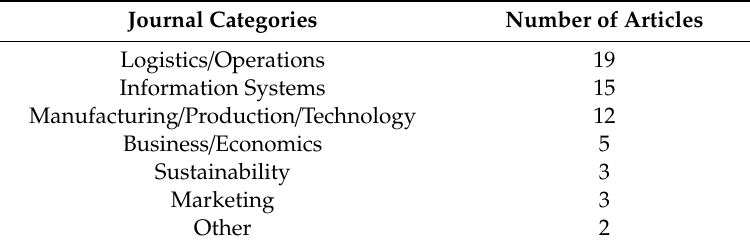
Table 3. Journal categories.